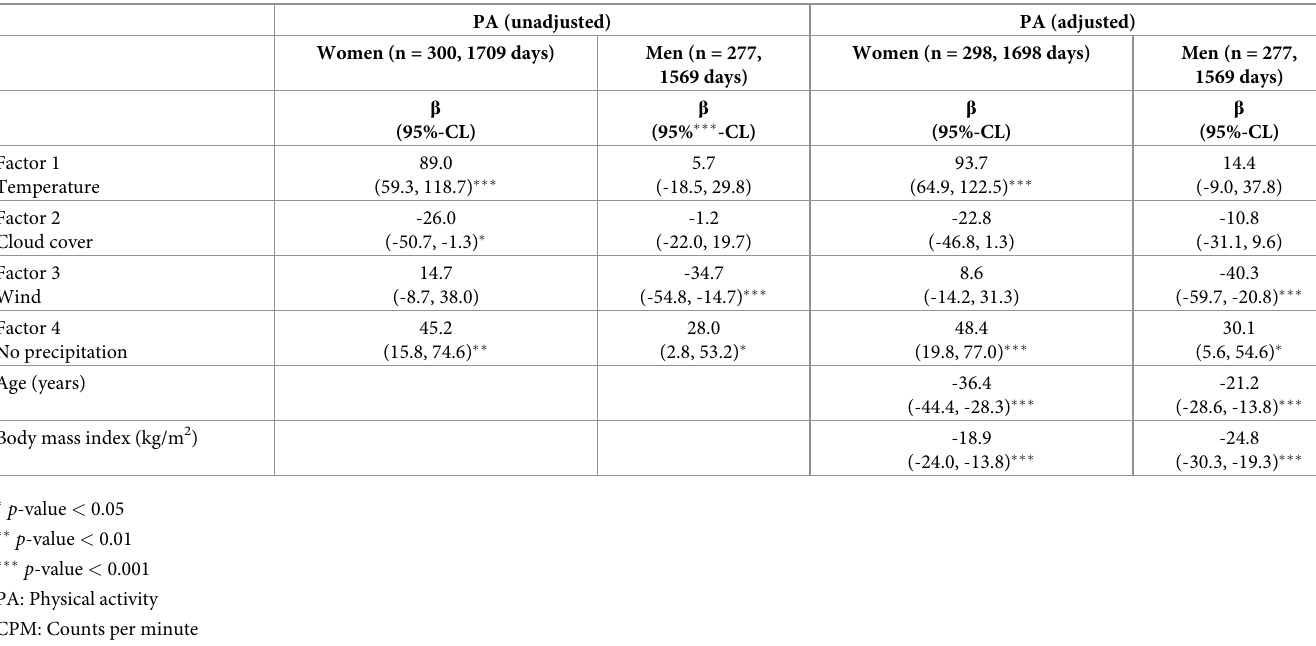
Table 3. Association of PA (average accelerometer CPM) and meteorological